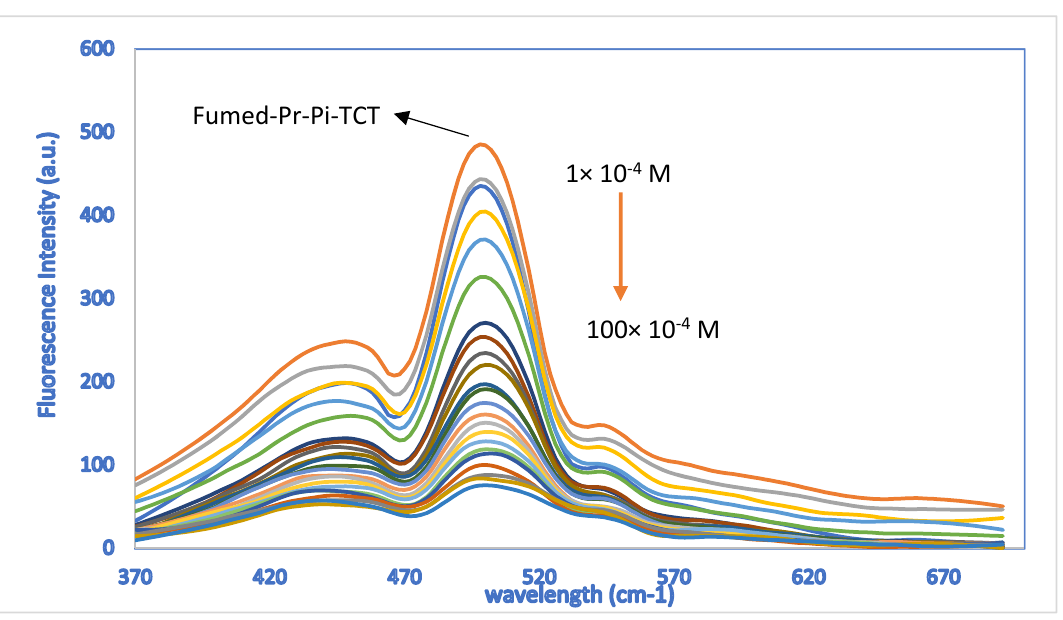
Figure 6. Fluorescence response of fumed-Pr-Pi-TCT (3 mL H ₂ O suspension, 0.2 g L − 1 ) after adding different concentrations of CN − .